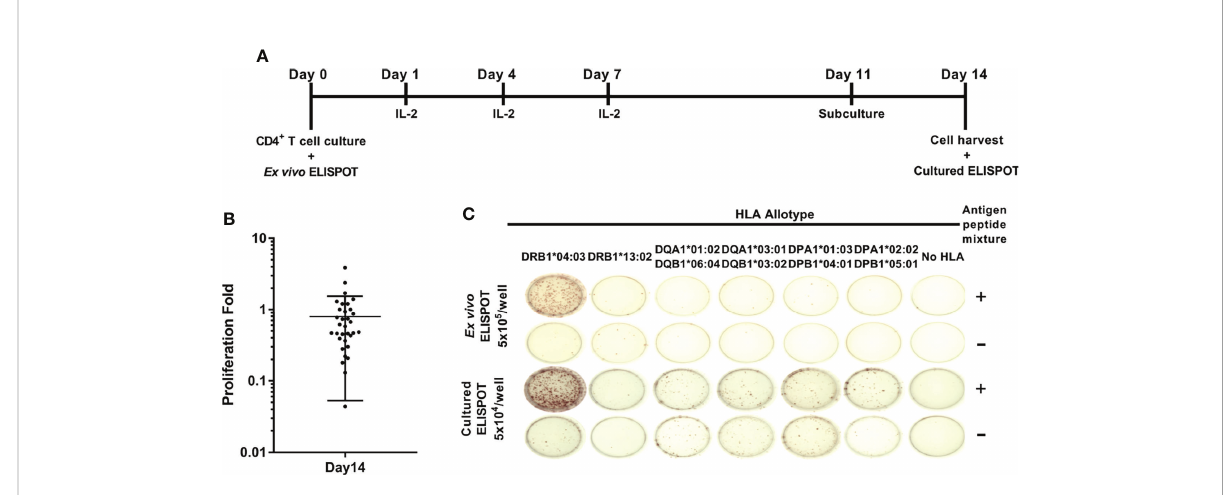
FIGURE 1 Schematic representation of ex vivo and cultured ELISPOT. (A) In vitro culture of antigen-speci fi c CD4 + T cell for cultured ELISPOT. As the M. tuberculosis antigens, a mixture of peptide pools of TB10.4, Ag85b, ESAT-6, and CFP-10 was used. (B) The proliferation folds of CD4 + T cells during 14 days of culture. Error bars indicate the mean ± standard deviation. (C) Representative ex vivo ELISPOT and cultured ELISPOT of HD04 using aAPCs expressing a single HLA class II allotype pulsed without antigens (-) or with M. tuberculosis antigens (+). *Notation of the HLA